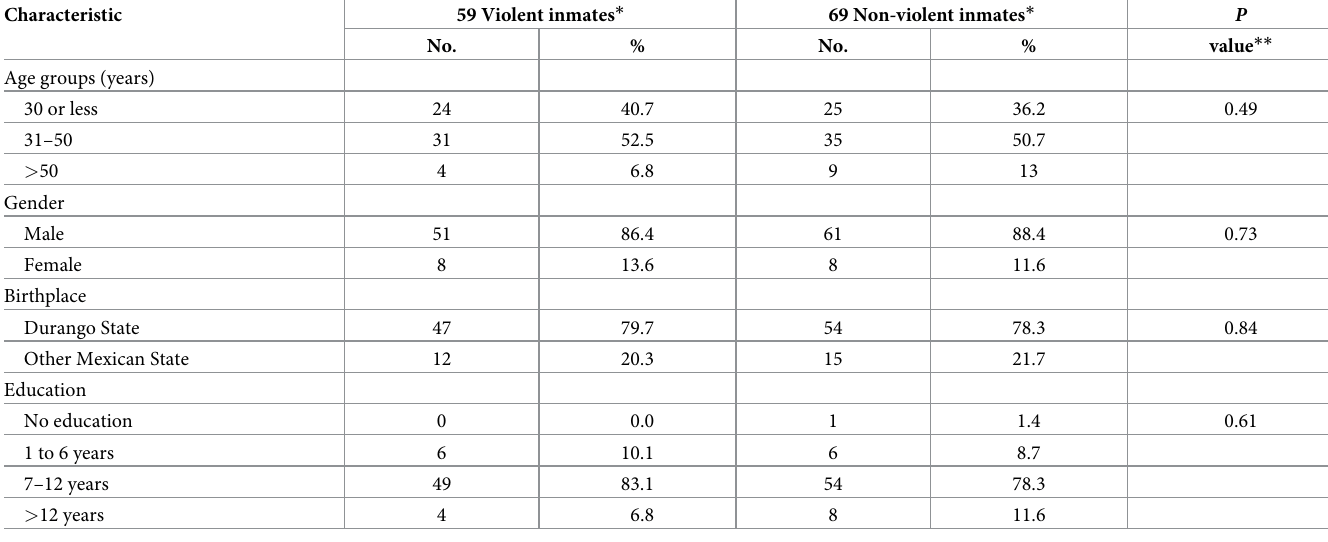
Table 1. Sociodemographic characteristics of the study